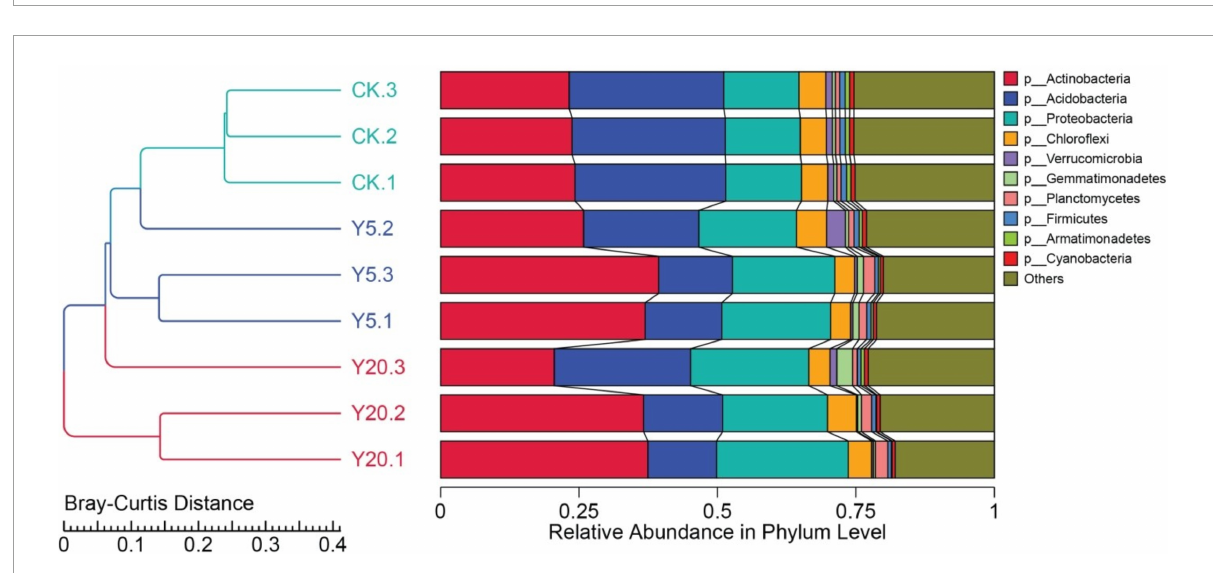
FIGURE2 The phylogenetic relationship based on Bray–Curtis distance and histogram at the phylum level showing the composition and structure of the bacterial communities of M. integrifolia treatments [1-year monoculture orchard (CK) = CK.1 , CK.2 , and CK.3 ; 5-year monoculture orchard (Y5) = Y5.1 , Y5.2 , and Y5.3 ; and 20-year monoculture orchard (Y20) = Y20.1 , Y20.2 , and Y20.3